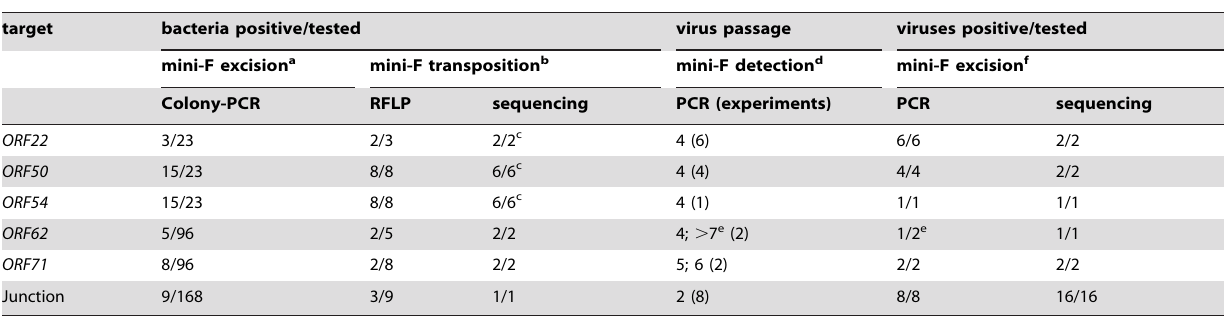
Efficiency of the mini-F transposition and the mini-F